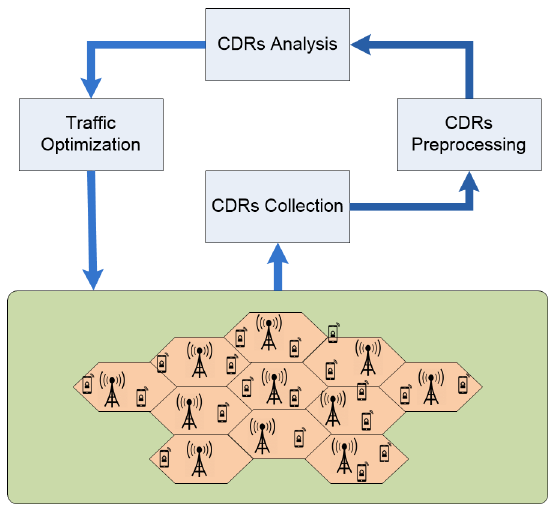
Figure 17. Demonstration of CDRs driven